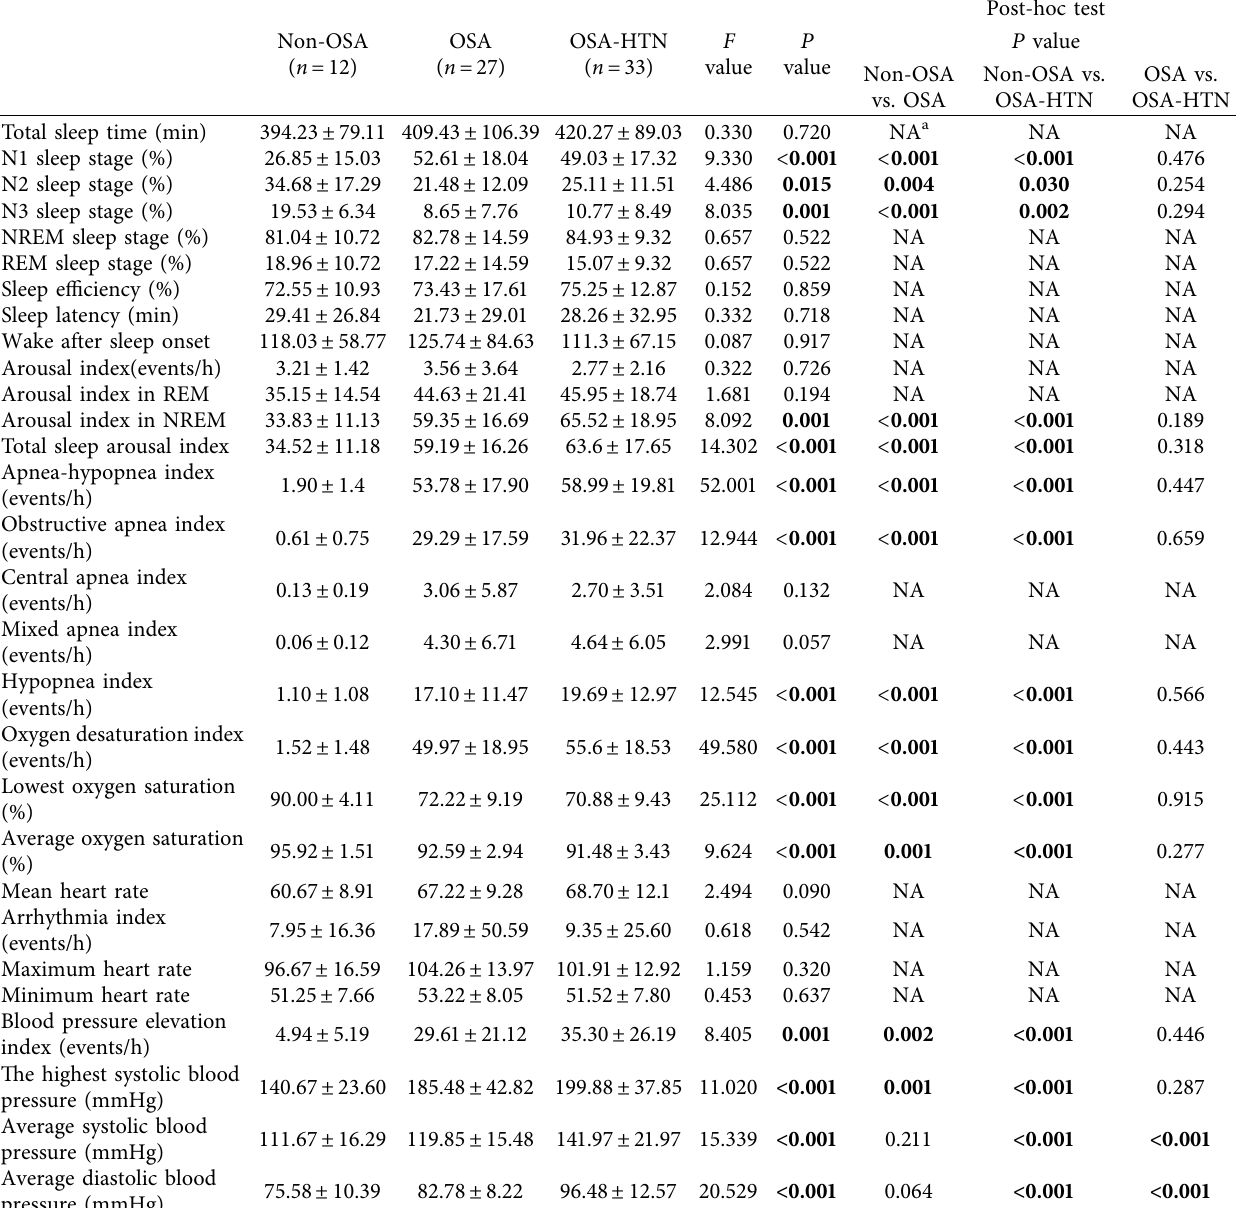
Table 2: Polysomnographic data analysis among non-OSA, OSA, and